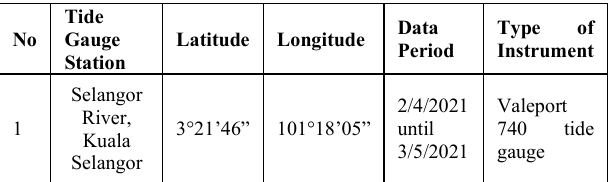
Table 1. Coordinates and period of data for tide gauge station